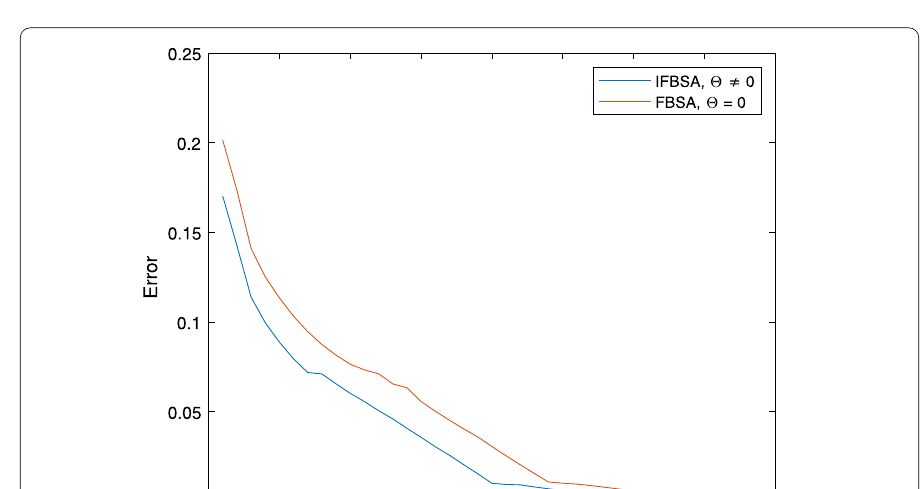
Figure 1 Graph of IFBSA and FBSA plotted for Choice 1 with N = 20